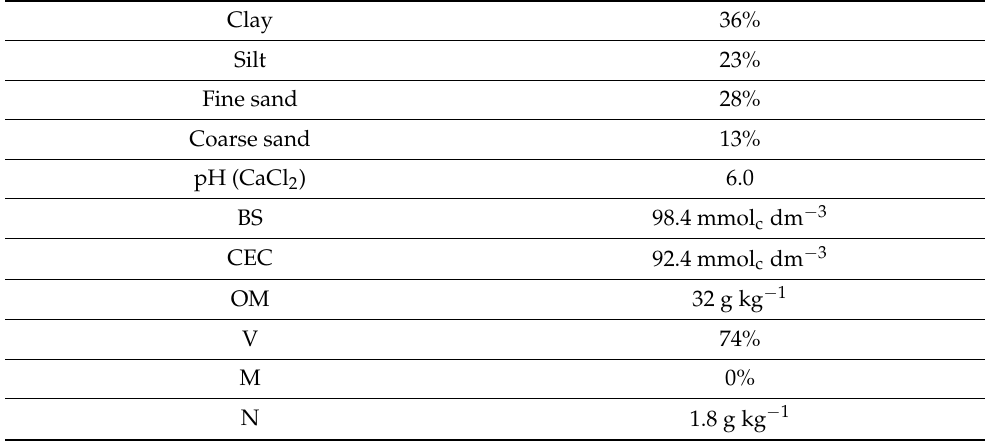
Table 1. Physical and chemical characteristics in depths between 0 and 20